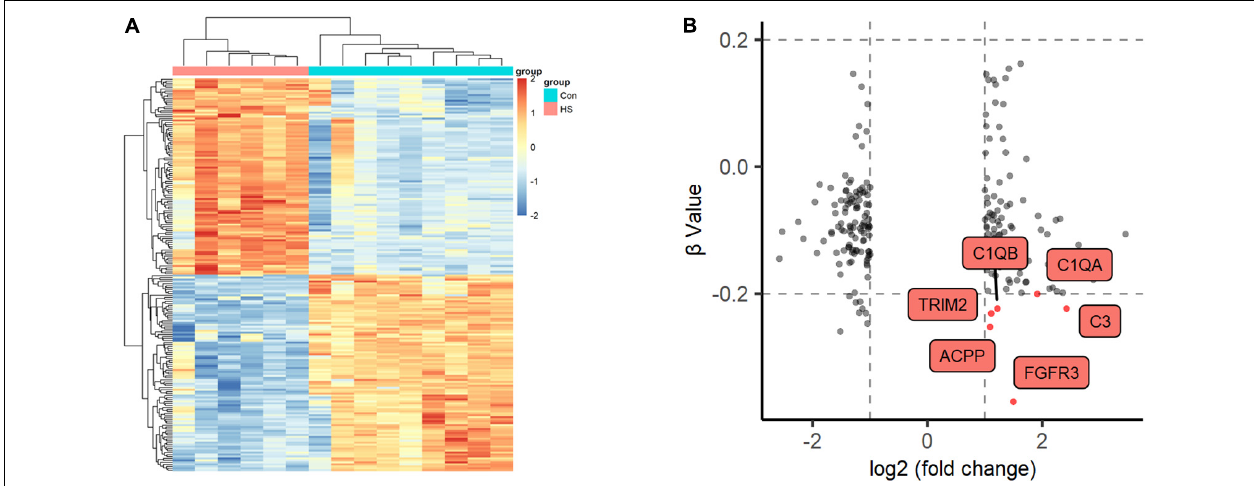
FIGURE 4 | Methylation profiles of Global DNA. (A) Two-dimensional hierarchical clustering of the significantly differential methylation signatures between TLE+HS and NTP (TLE+HS in red, NTP in blue). (B) Nine quadrant diagram of the significantly differential methylation and mRNA signatures of Genes. TLE+HS, epilepsy with hippocampal sclerosis; NTP, normal temporal or parietal cortices.